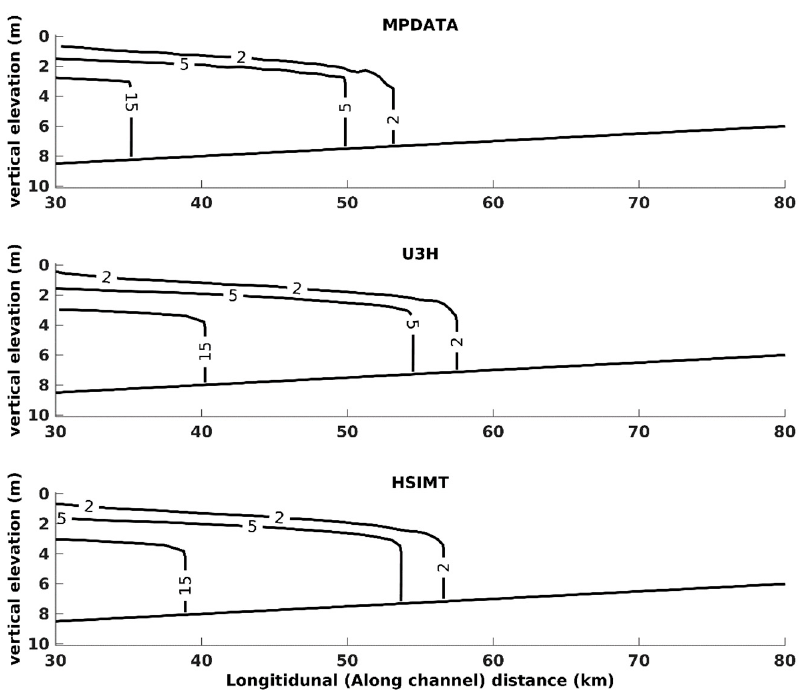
Figure 7. Case 4: Estuary test case with a rectangular geometry; Comparing salt intrusion (2, 5, and 15 psu isohalines) with the three different advection schemes at the end of 30 days with 2, 5, and 15 psu isohaline.